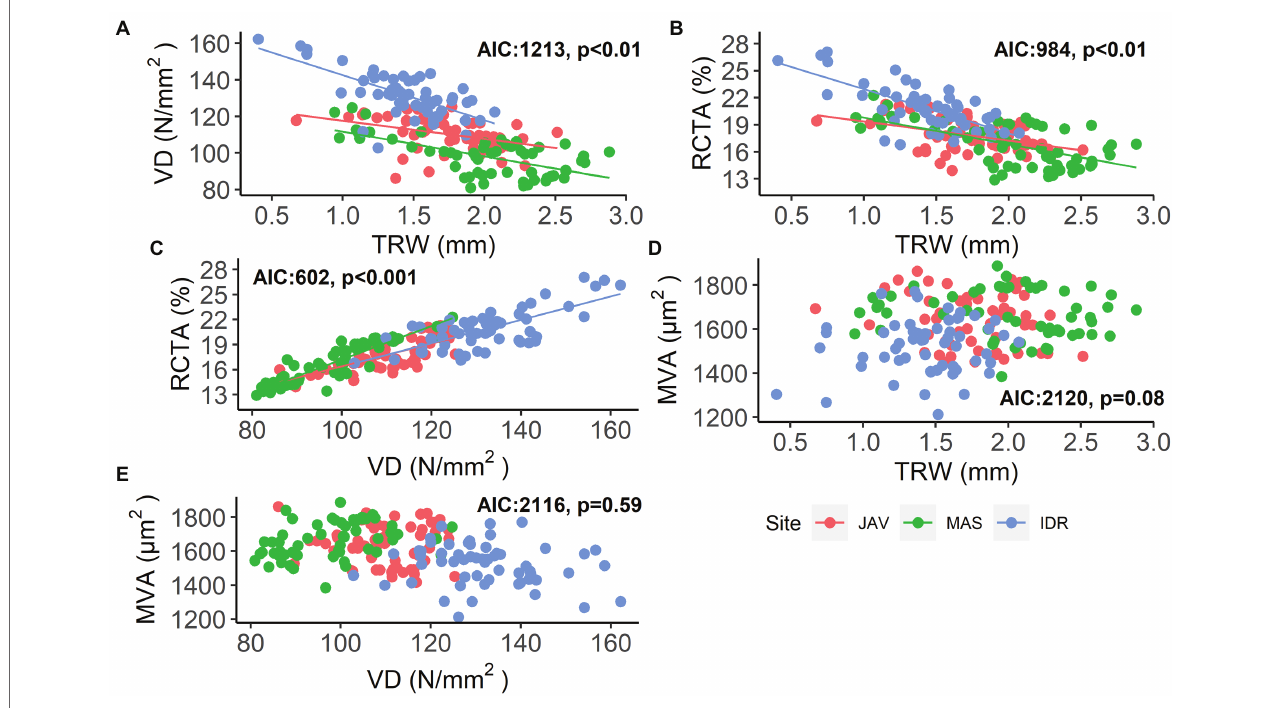
FIGURE 3 | Relationships between: (A) vessel density (VD) and tree-ring width (TRW), (B) relative conductive area (RCTA) and TRW, (C) RCTA and VD, (D) mean vessel area (MVA) and TRW, and (E) MVA and VD in beech at Javornik (JAV), Ma š un (MAS), and Idrija (IDR) with models Akaike information criterion (AIC) and significance level. Further statistical information for the presented generalized linear models is given in Supplementary Tables S2 – S6